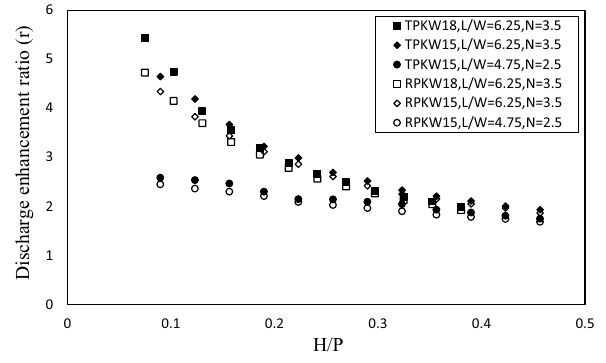
Fig. 8 Variation of discharge enhancement ratio ( r ) with